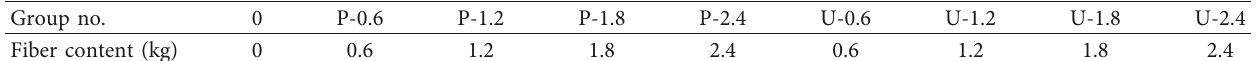
Table 2: Mix proportion of fiber concrete in each group (measured in m 3 ).